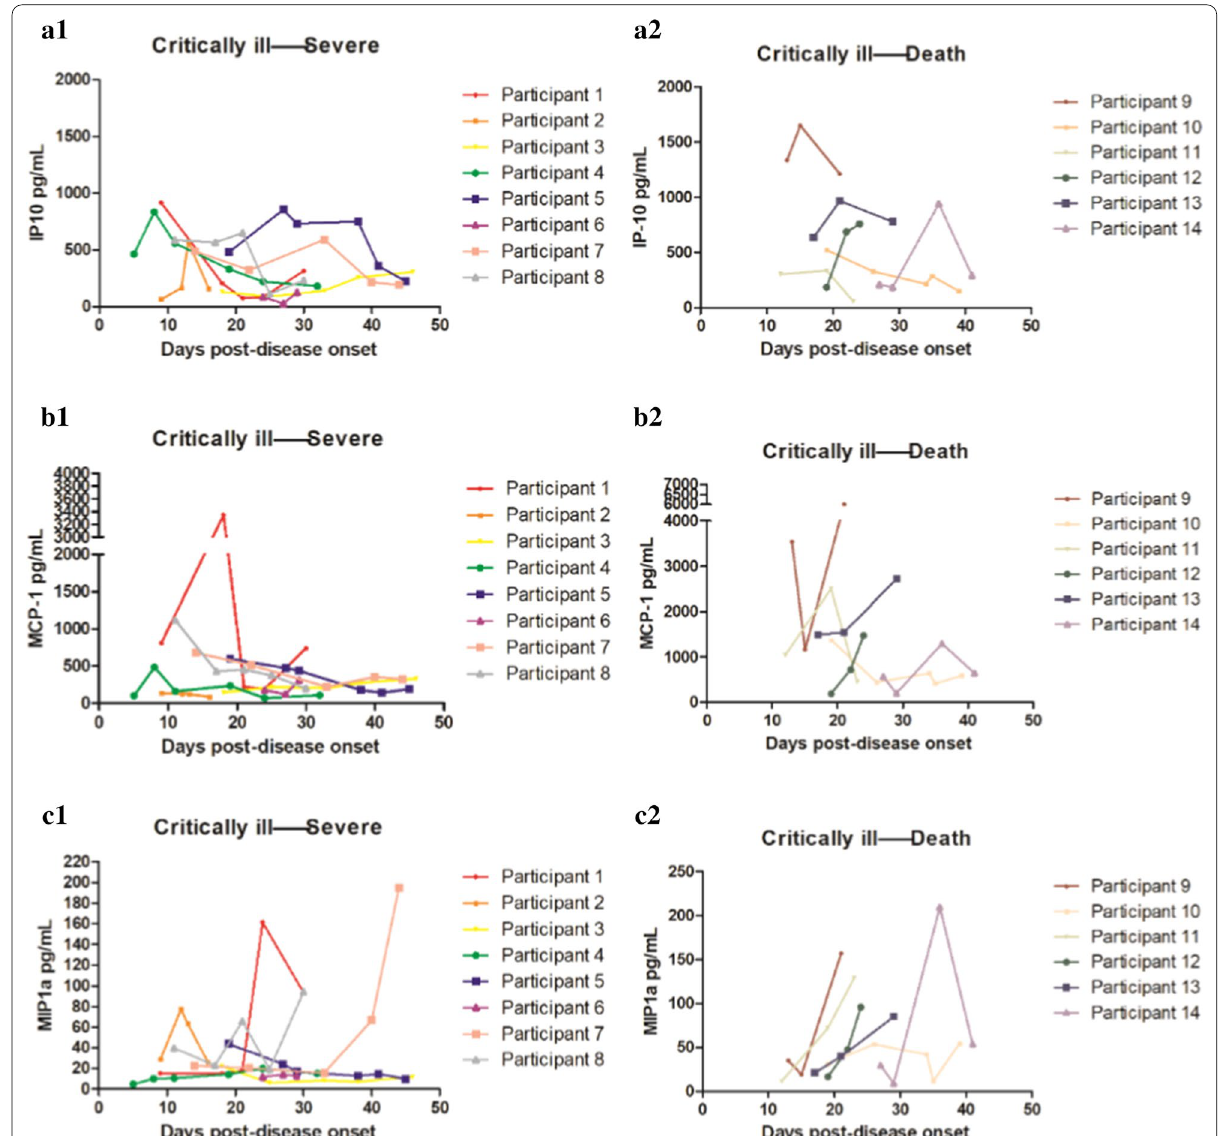
Fig. 3 Dynamic changes of coagulation and thrombosis-related indicators in the two outcomes after the critical illness turned into severe and the critically ill patients eventually died. A.1 , A.2 Dynamic changes of IP-10: when the critical illness turned into severe, the IP-10 level in most patients increased at first and then decreased along the 20–30 days of the disease. When the critical illness turned into death, the IP-10 level in most patients decreased at first and then increased in approximately 20–30 days of disease progression. B.1 , B.2 Dynamic changes of MCP-1: when the critical illness turned into severe, the MCP-1 level gradually decreased in most patients. When the critical illness turned to death, the MCP-1 level gradually increased in most patients. C.1, C.2 Dynamic changes of MIP1α: when the critical illness turned into severe, the MIP1α level gradually decreased in most patients. When the critical illness turned into death, the MIP1α level gradually increased in most